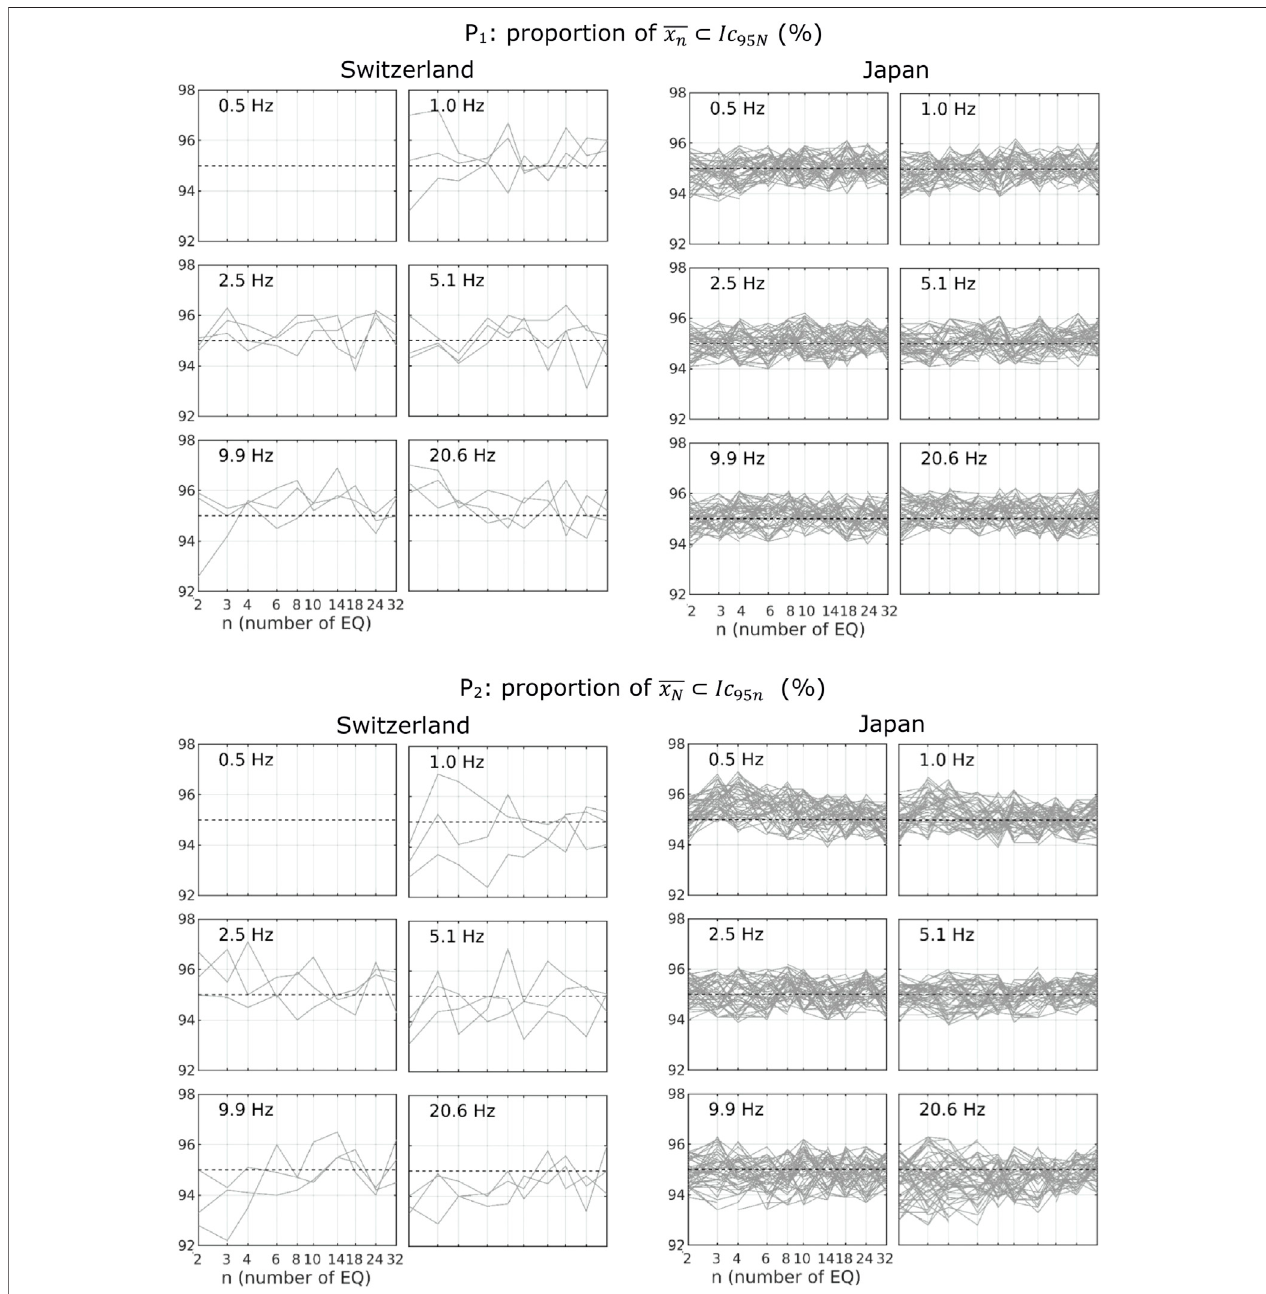
FIGURE 8 | Evaluation of P1 and P2 as a function of the number of events n at 6 frequencies (0.5, 1.0, 2.5, 5.1, 9.9, and 20.6 Hz) for three Swiss sites and 60 Japanese sites.